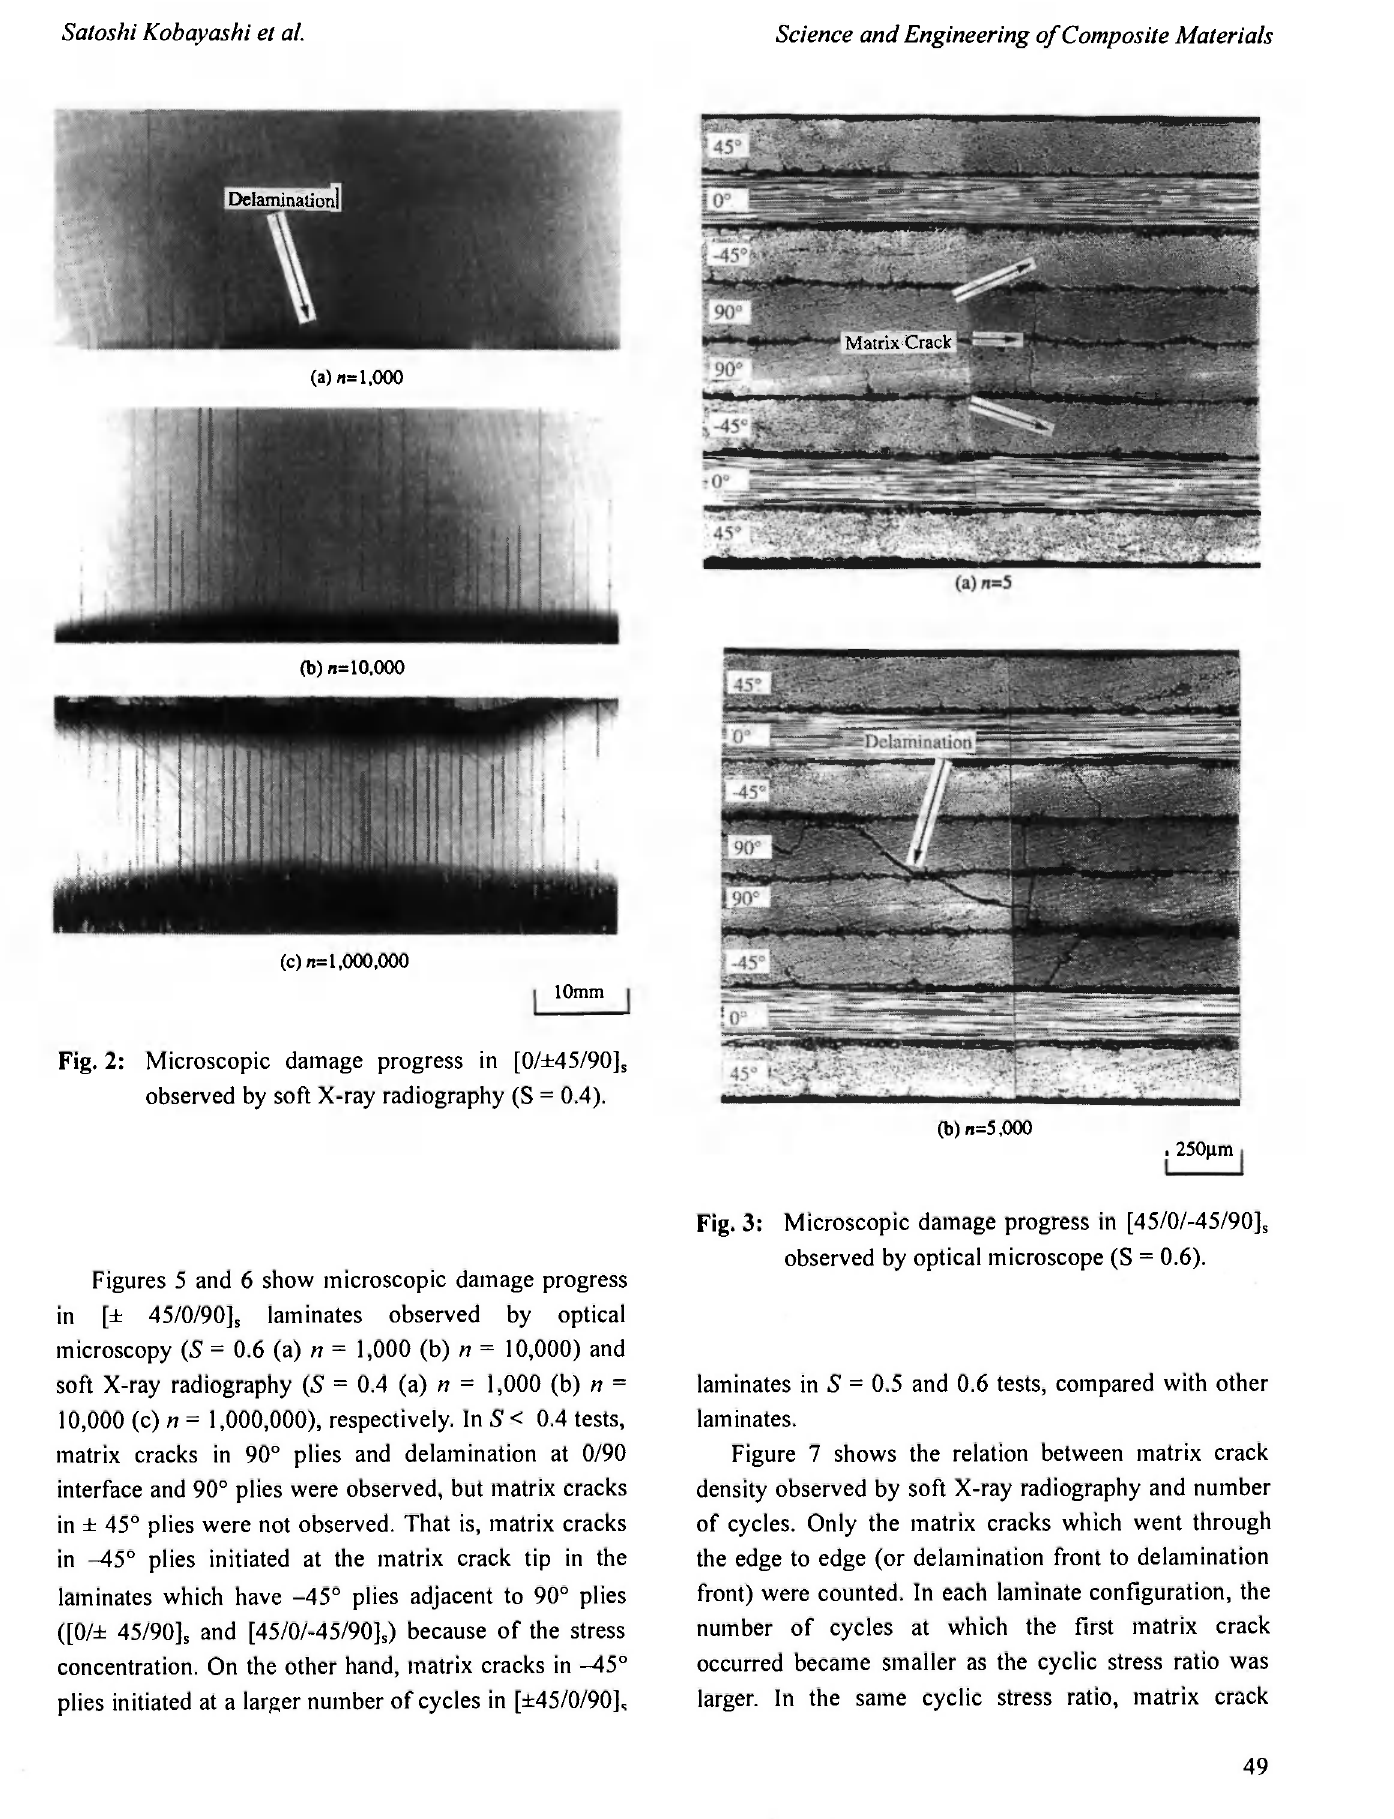
Fig. 3: Microscopic damage progress in [45/0/-45/90] s observed by optical microscope (S = 0.6).